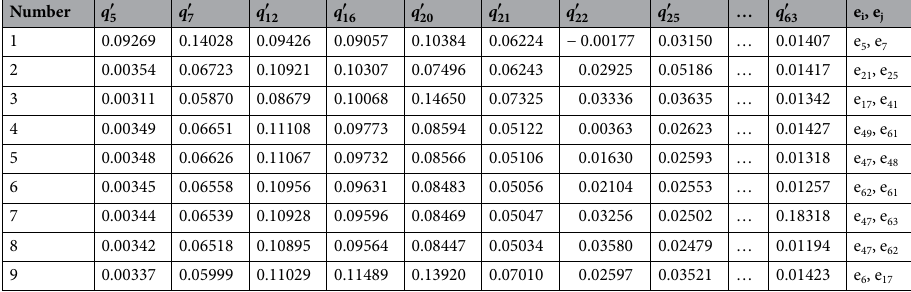
Table 7. Experimental ventilation system with a multifault instance test